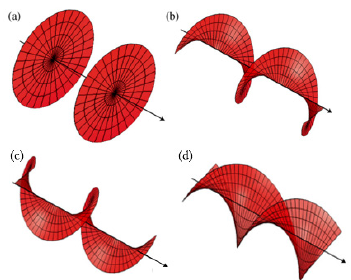
Figure 1. Helical phase fronts for ( a ) l = 0, ( b ) l = 1, ( c ) l = − 1, and ( d ) l = 2. Reprinted with permission from [19], Copyright 2011 The Optical Society of America.